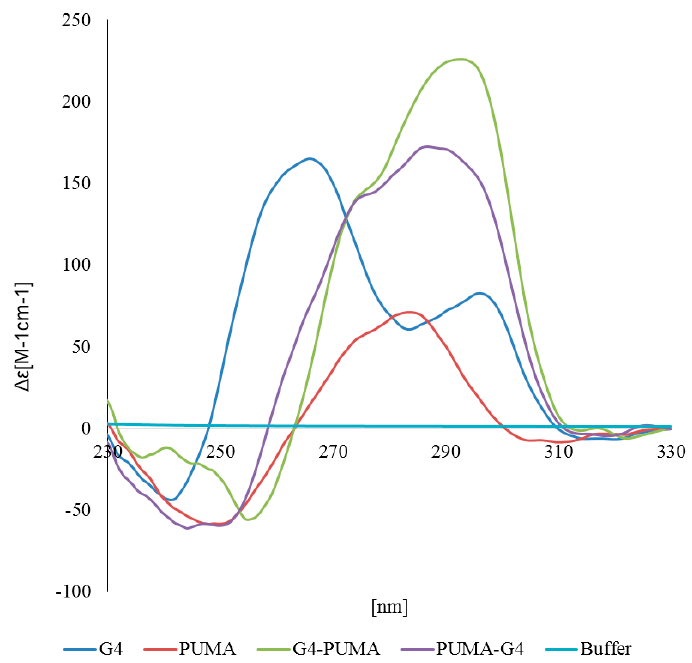
Figure 1. Circular Dichroism }CD] spectroscopy of used DNA sequences. CD spectra of the buffer (light blue), and oligonucleotides from the Table 1 (G4, blue, PUMA-red, G4-PUMA-green, PUMA-G4 violet).